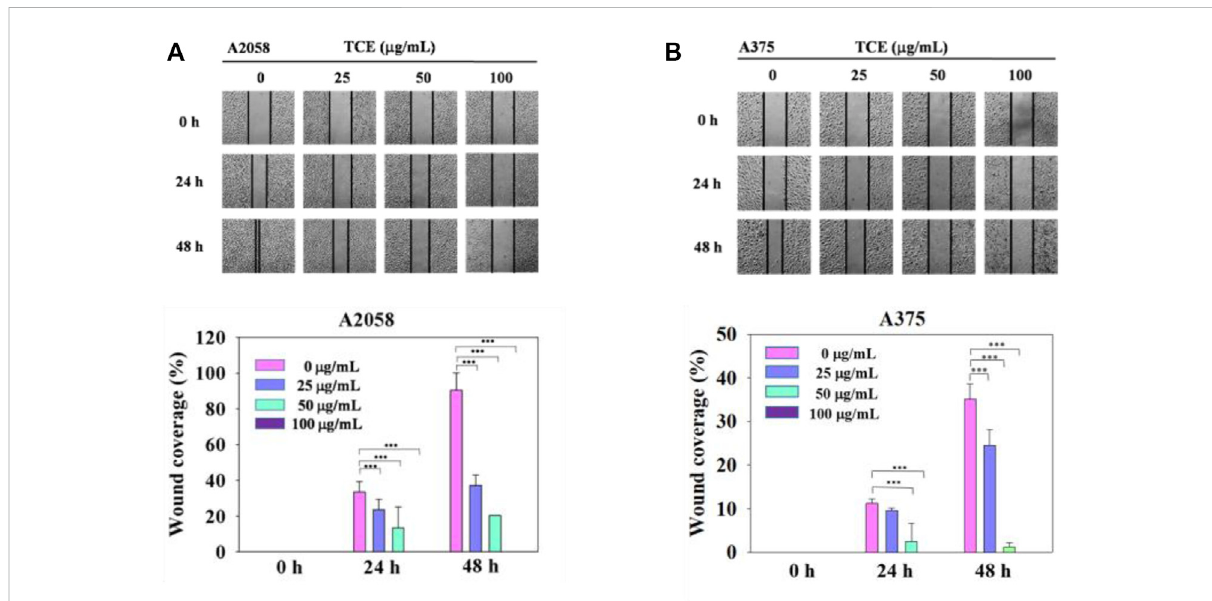
The effects of TCE on the cell migration of A2058 and A375 cells. (A,B) Photographs showed wound closure of A2058 and A375 cells treated with TCE (0, 25, 50, 100 μ g/mL) and 0, 24, 48 h. Cell wound healing assay was performed as described in the Materials and Methods. % Wound coveragewasdeterminedbytherateofcellsmovingforwardthescratchedareaupontime.Thevaluesofpercentagewoundclosure±SDofatleast three independent experiments. Comparisons were performed using two-way ANOVA with post hoc Turkey ’ s test (*** p <